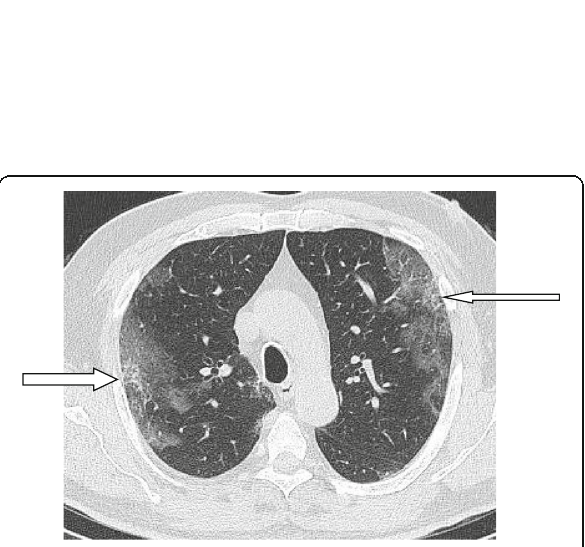
Fig. 8 Patient with COVID-19 pneumonia, 8 days after appearance of symptoms with ground glass infiltration and